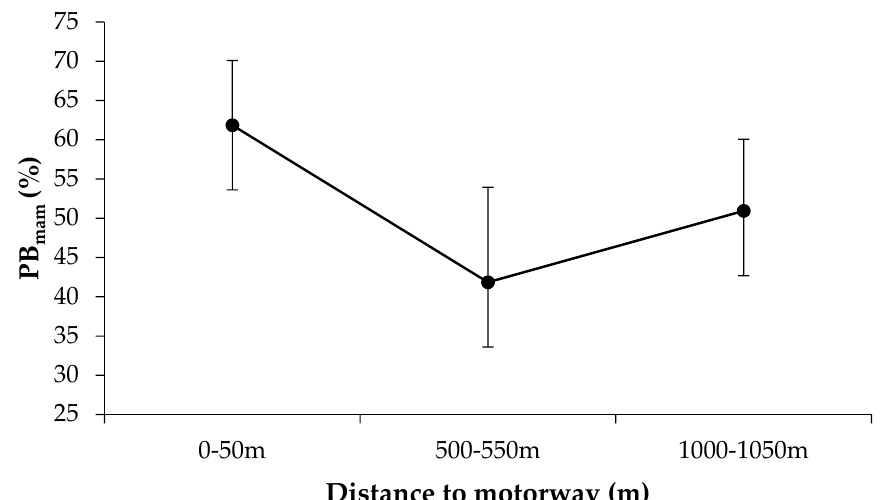
Figure 2. Weighted marginal means and confidence intervals (CI–95%) of percentages of fresh small mammal biomass ( PBmam ) in scats from the three distance-from-road bands considered. The variable was arcsine square root transformed for analysis but its graphical representation has been back-transformed to facilitate its interpretation. Note that the Y axis does not start at 0%.